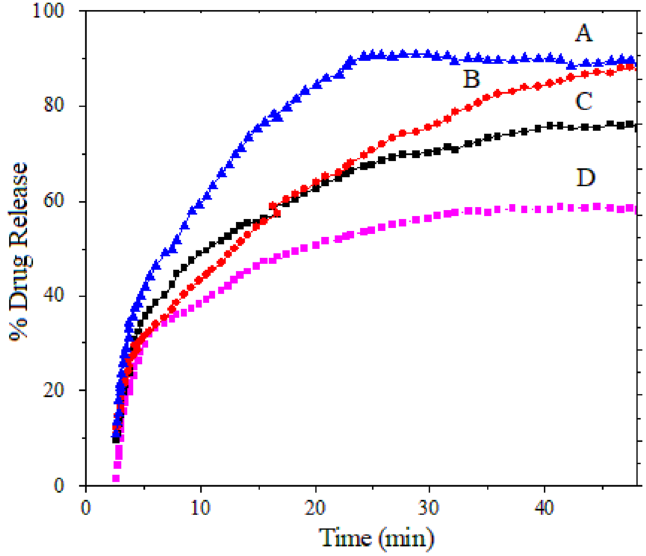
Figure 10. Release profiles of sorafenib from its physical mixtures ( A ) FPEGSO-MLDH; ( B ) FPVASO-MLDH in phosphate-buffered solution at pH 4.8; ( C ) FPEGSO-MLDH; ( D ) FPVASO-MLDH in phosphate-buffered solution at pH 7.4.